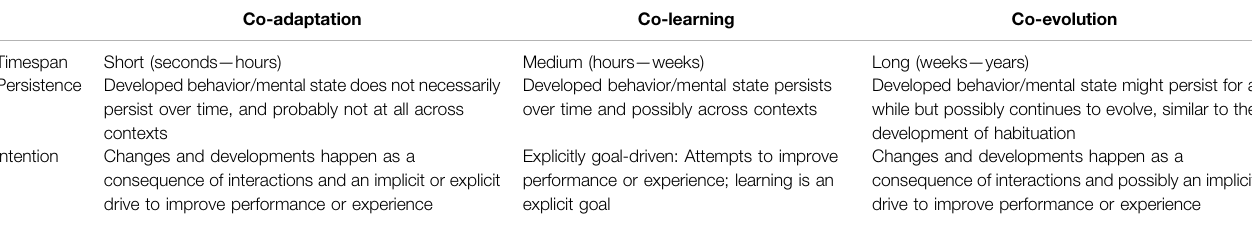
TABLE 1 | The concepts co-adaptation, co-learning and co-evolution de fi ned in terms of timespan in which they occur, persistence and